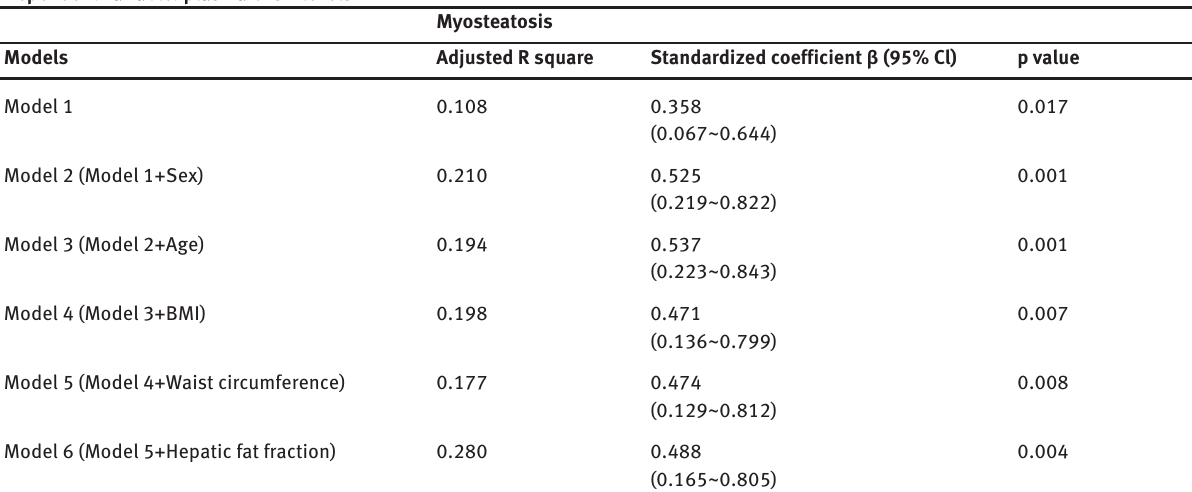
Table 3: Myosteatosis is positively associated with plasma CTSD levels independent of sex, age, BMI, waist circumference and hepatic fat fraction